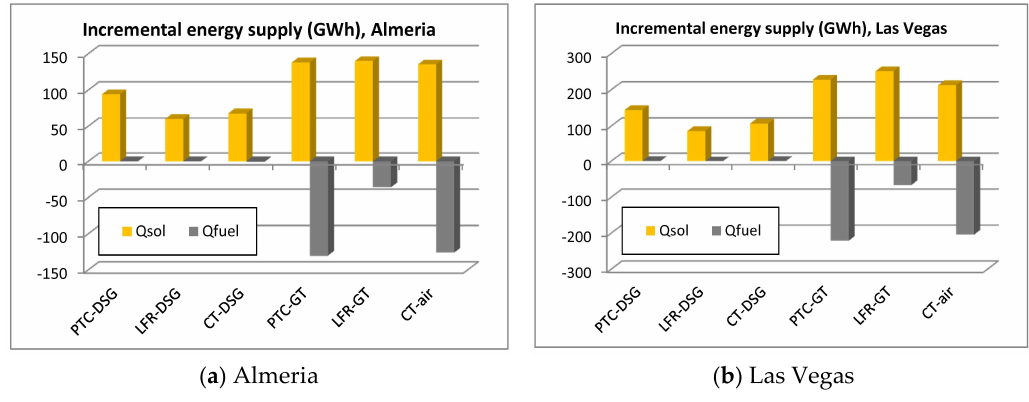
Figure 9. Solar contribution and fuel saved.